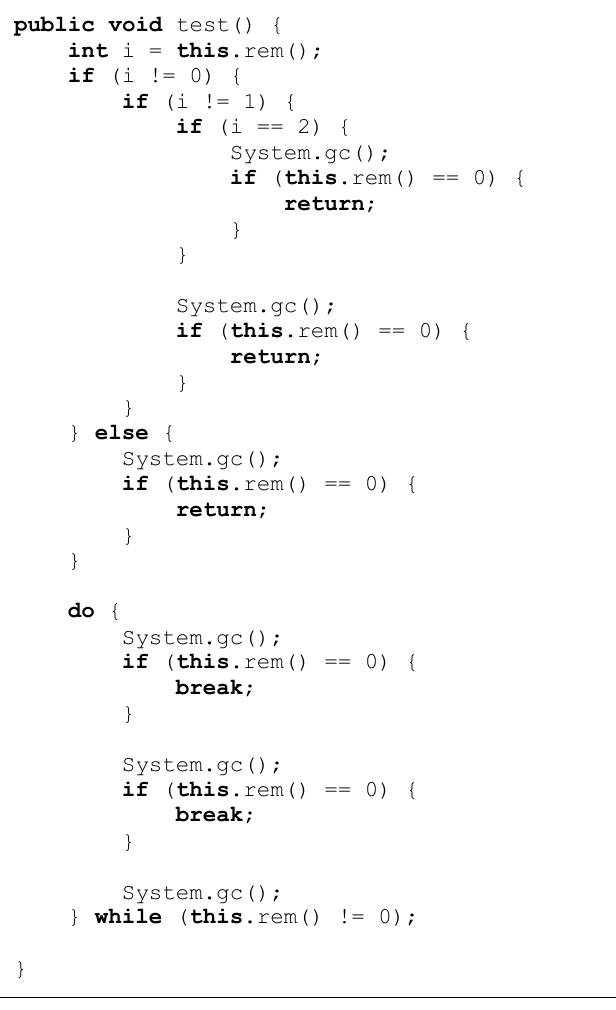
Fig. 13. Fernflower decompilation